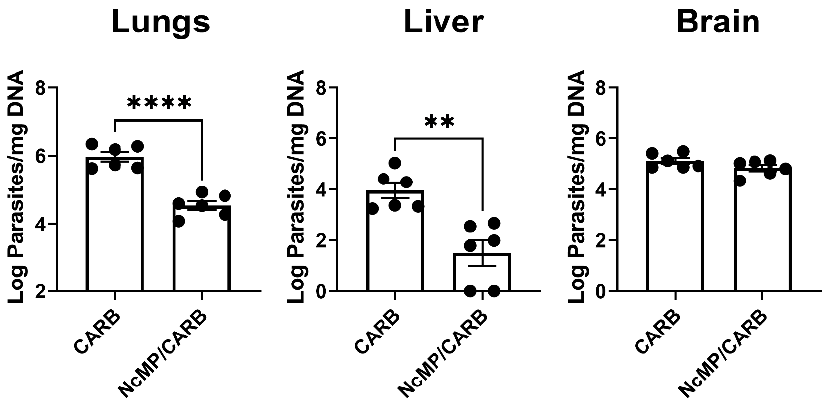
experiments that yielded concordant results ( n = 4 group; * p < 0.05; **** p < 0.0001, Mann–Whitney).